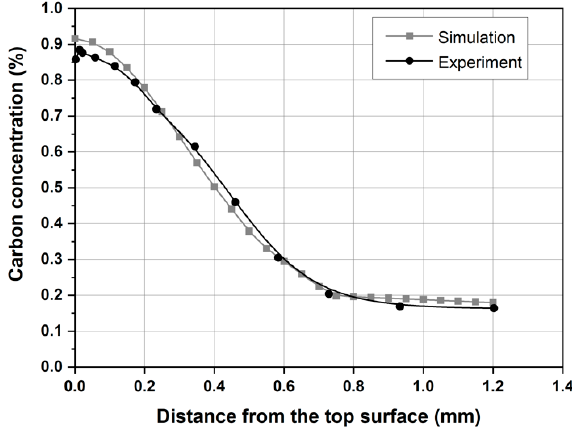
Figure 5. Comparison of simulation and experiment carbon concertation.